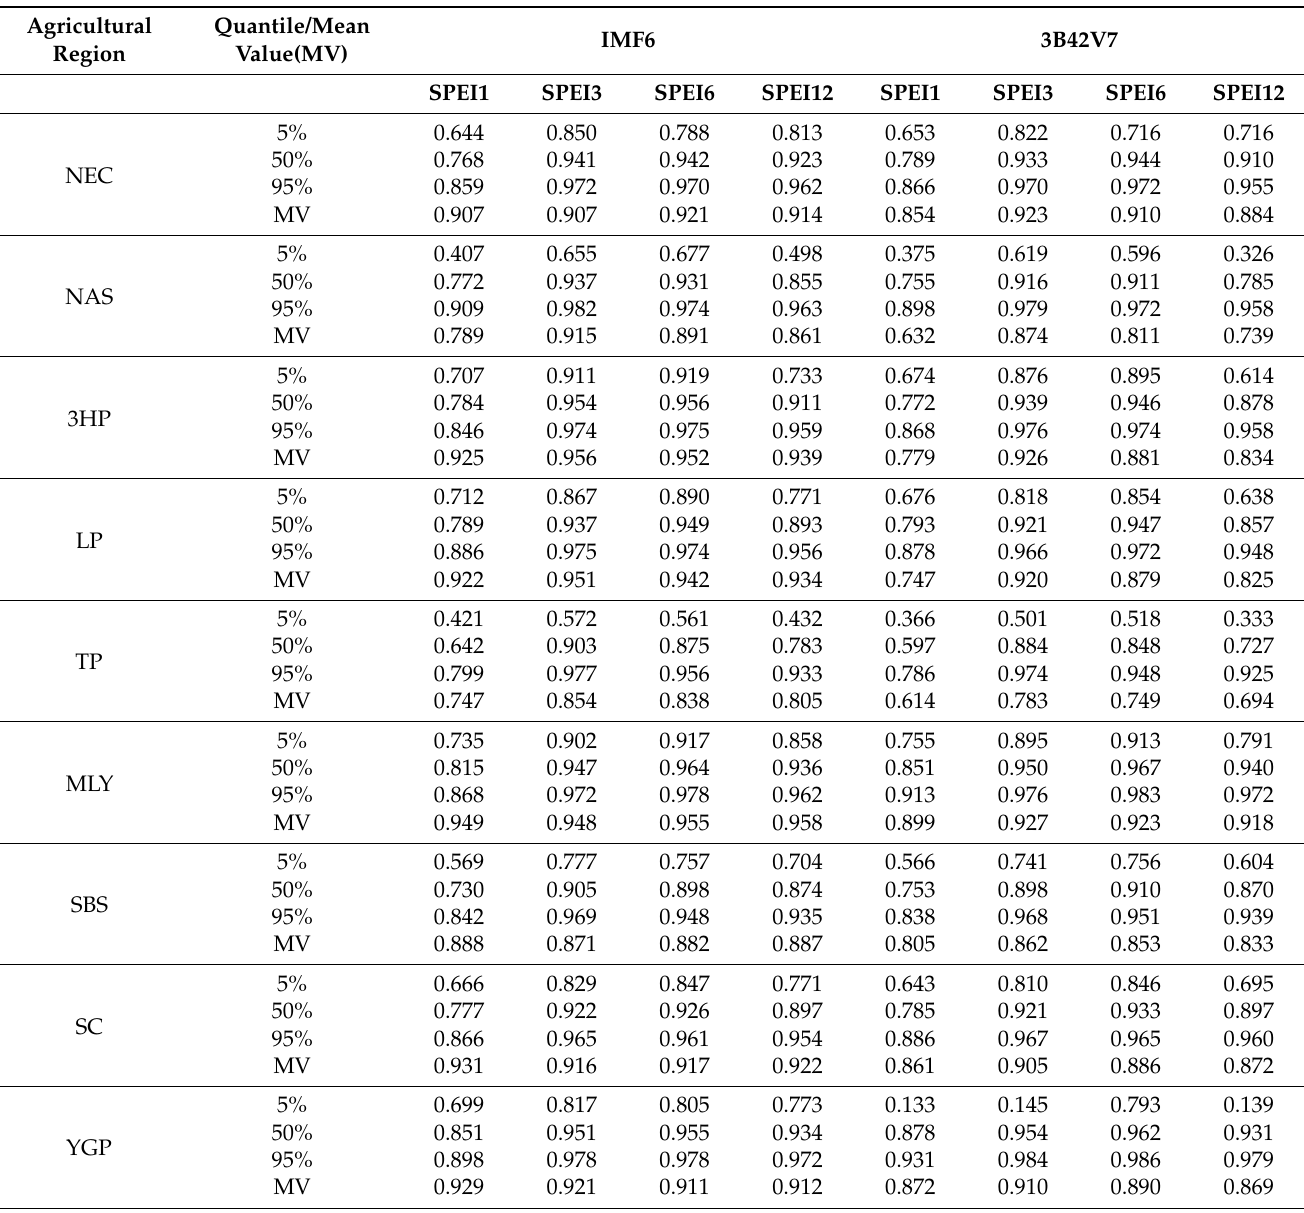
Table 6. Same as Table 5 but for IMF6 and